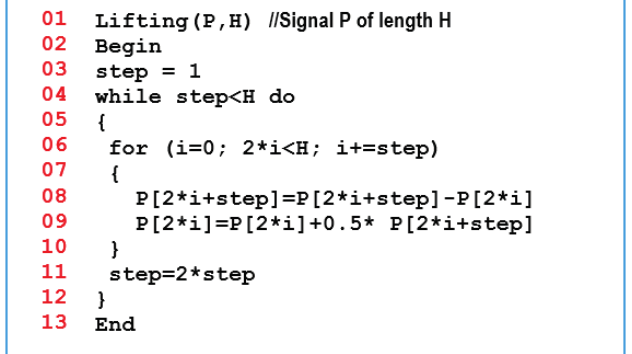
Figure 1. The Lifting compression algorithm.